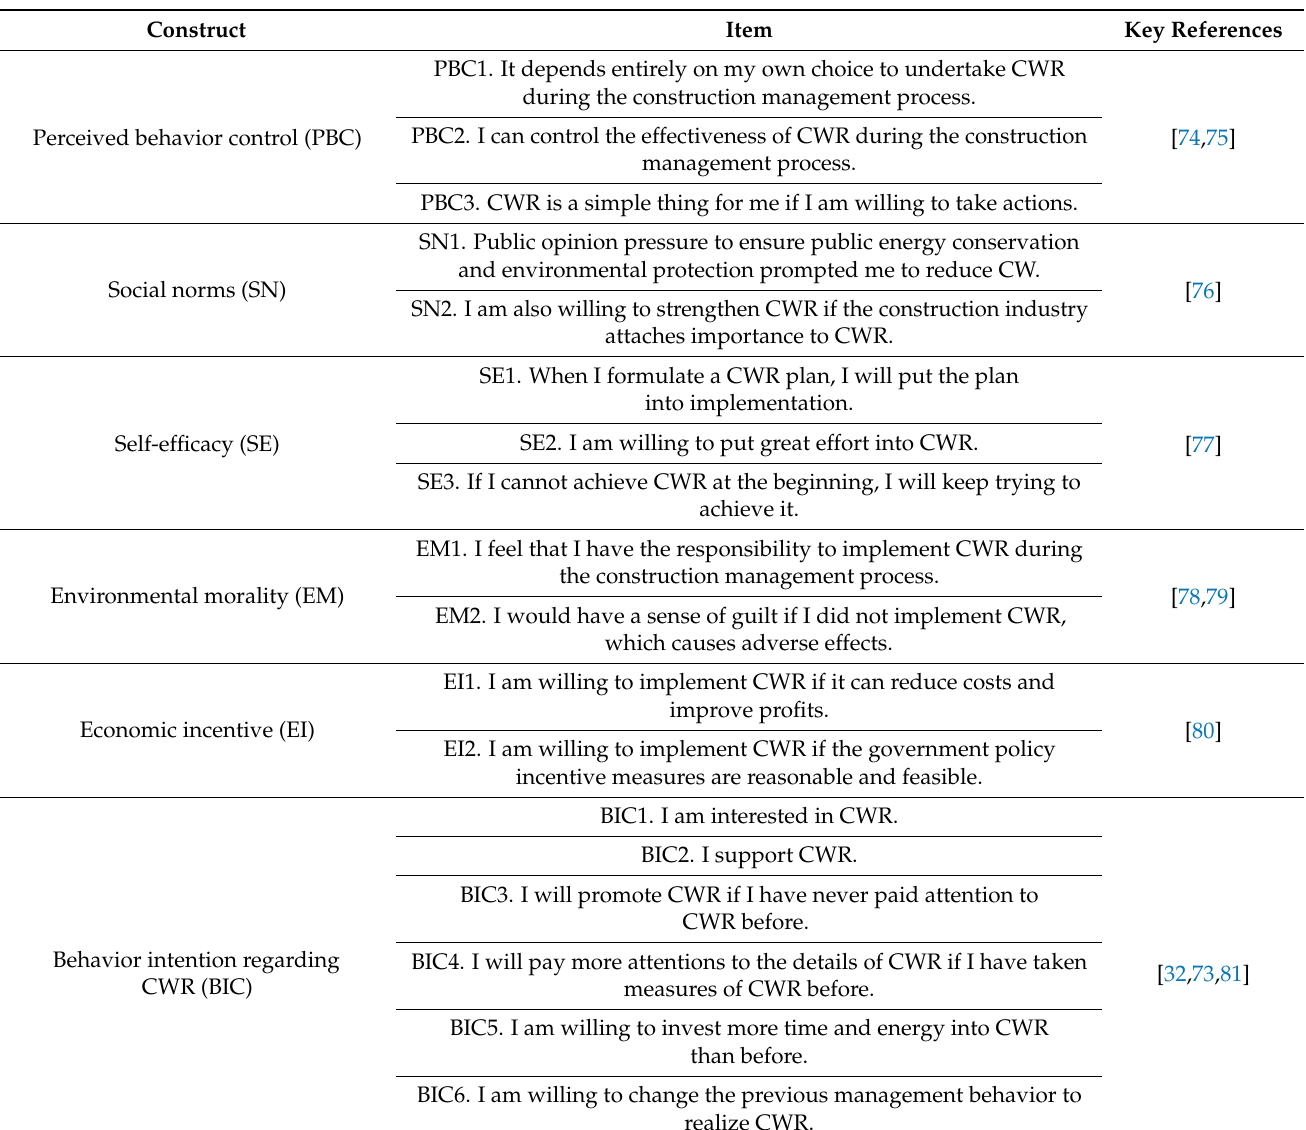
Table 2. The measurement of relevant